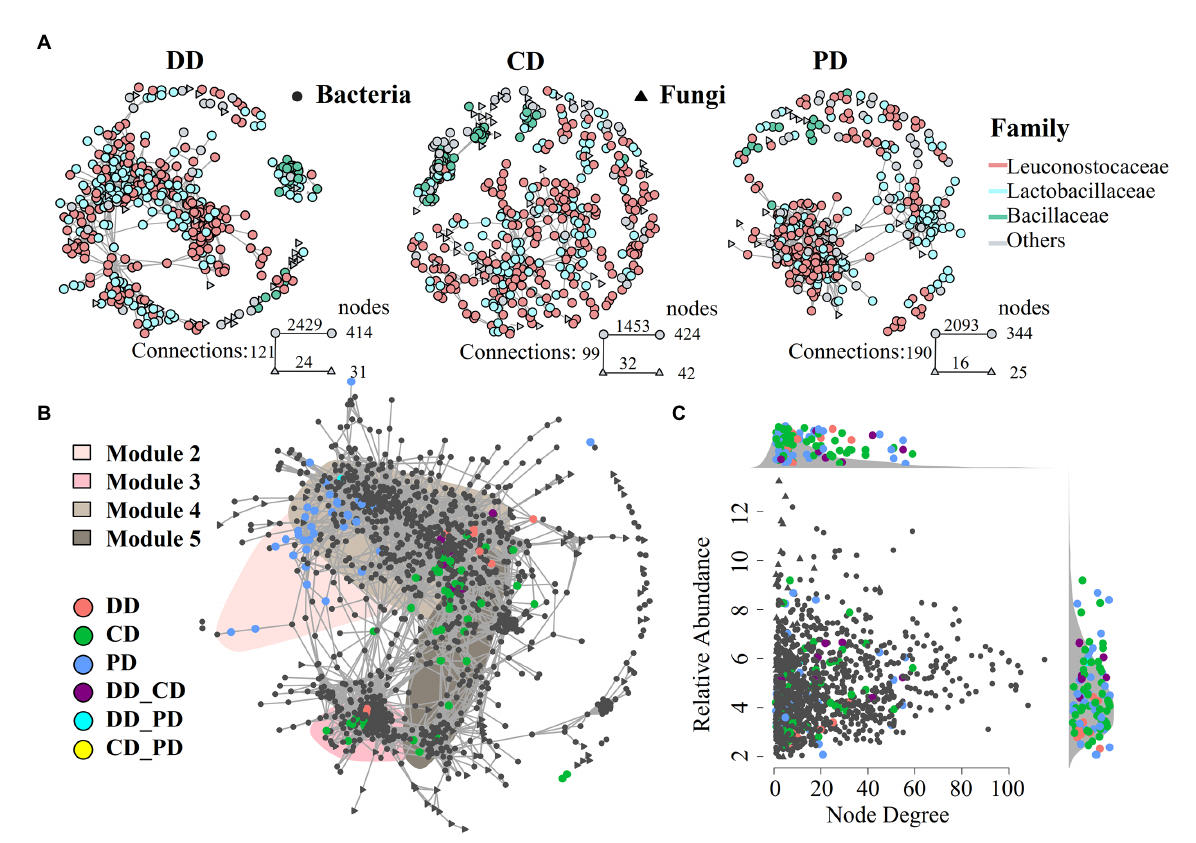
FIGURE 5 The MTD microbial community co-occurrence patterns. (A) Co-occurrence network of different types MTD microbial communities ( ρ > 0.65, p < 0.001). (B) Full sample co-occurrence network and distribution of bioturbation responding significant ASVs ( bs ASV) under specific bioturbation, insensitive ASVs were colored in gray. The major network modules containing bs ASVs were shaded. Abbreviations connected with underscores such as DD_CD, DD_PD, CD_PD indicated the joint bs ASVs of different MTD. (C) Degree of co-occurrence and abundance of bs ASVs. Relative abundance (as counts per million, CPM) of all ASVs from the MTD microbiome co-occurrence networks is plotted as a function of their degree of co-occurrence. Side panels recapitulate the distributions of co-occurrence degrees and abundance for the bs ASVs compared to the density of